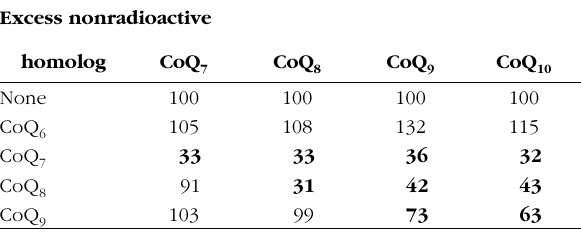
a Bolded numbers indicate inhibition of [U- 14 C]PhBa incorporation into the CoQ homolog. Table i. – sythesis of CoQ homologs in P. carinii is regulated by product feedback